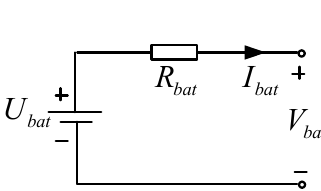
Figure 3. Rint model of the LiFePO 4 battery.